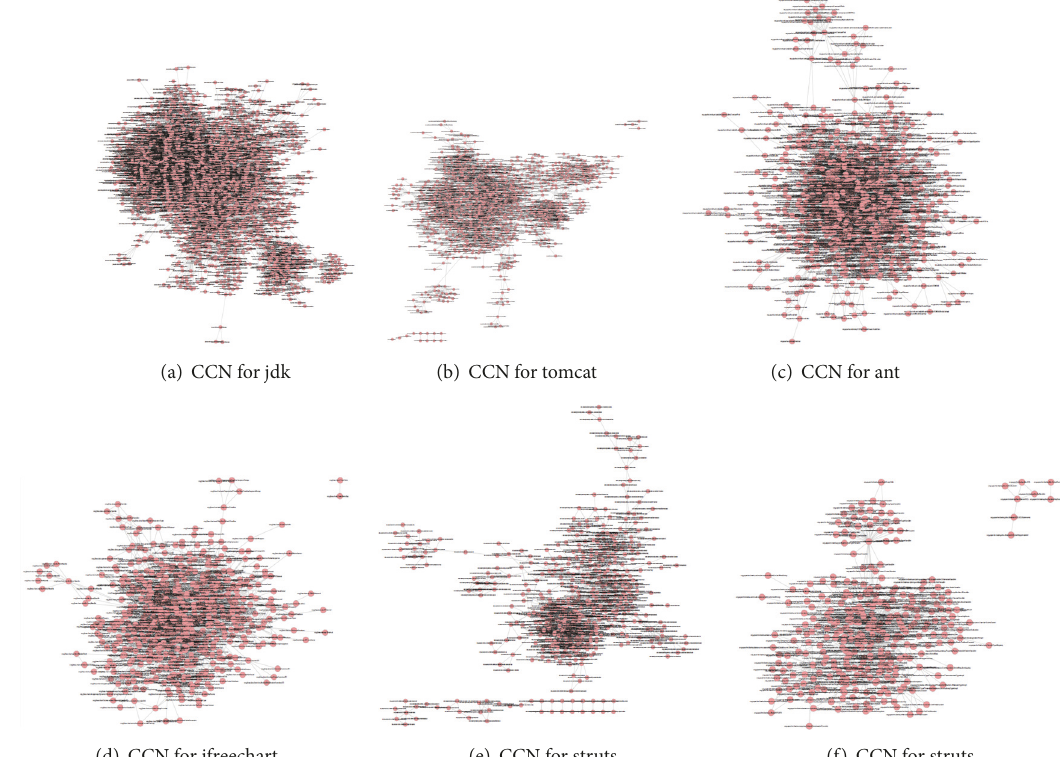
Figure 5: CCNs for the six subject systems. The source files of these figures can be downloaded from https://www.icloud.com/iclouddrive/ 0sSM4U7GmxiTLpLfpp0kxcDsg#complexity9414162supp